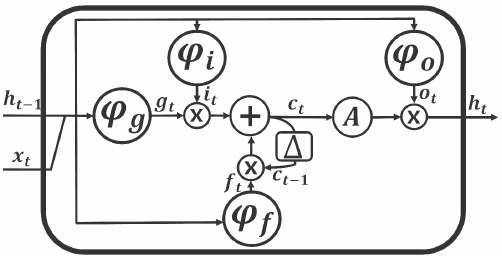
Figure 3. Structure of an LSTM RNN cell.